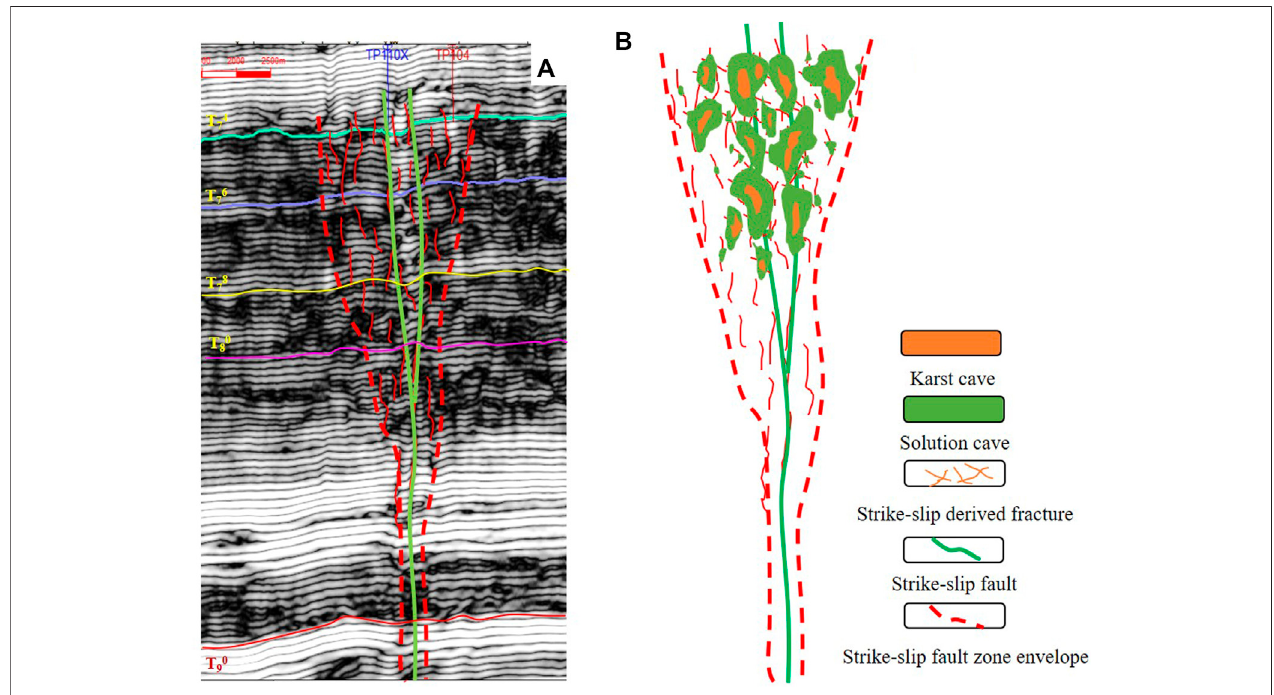
FIGURE2| Three-dimensionalgeologicalconceptualmodeloffault-controlledpaleokarstmodel. (A) Integratedofwellandseismicdataforgeologicalanalysis; (B) Schematic diagram of geological conceptual model.